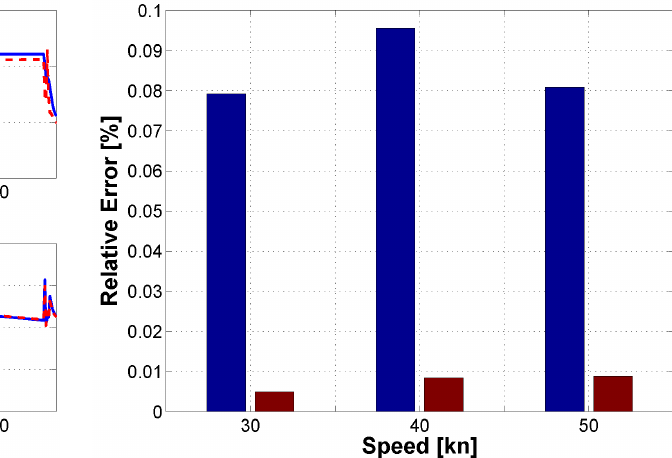
Figure 25: Average relative error for simulations at various air- speeds and glide-slope angles. Observer checked on the same samples considered for identification. Left bars: TPP-AOA, right bars: thrust coeflcient.